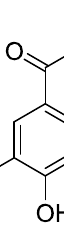
Figure 1. The chemical structure of ellagic acid.